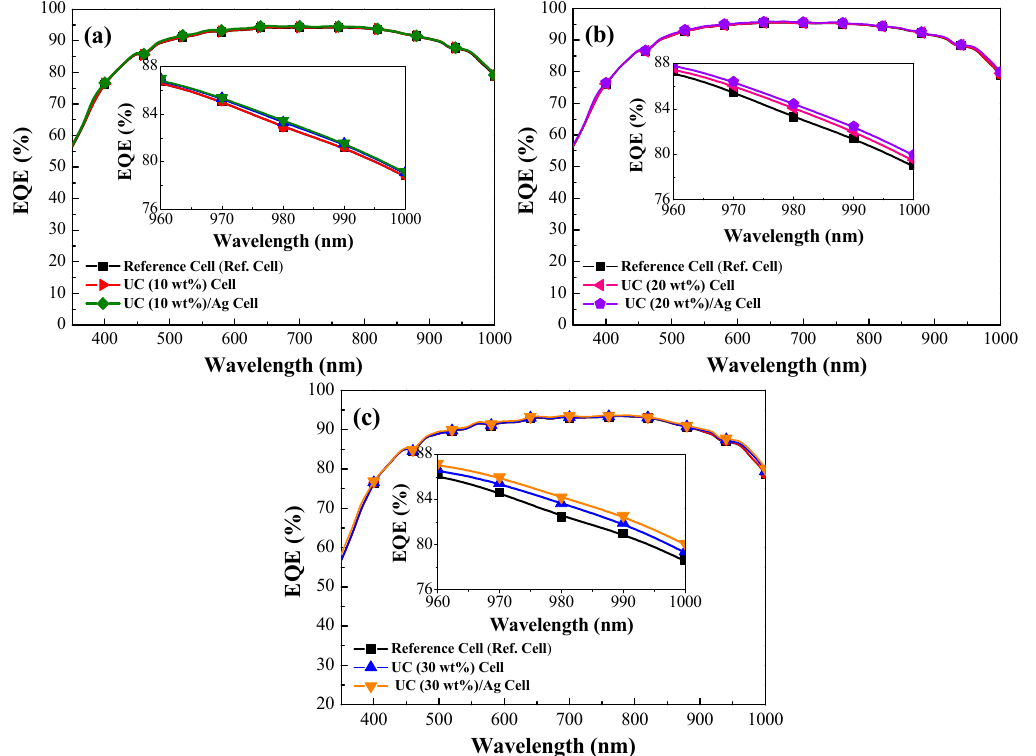
Figure 10. External quantum efficiency ( EQE ) response of reference cell, UC cell, and UC/Ag cell at phosphor concentration of ( a ) 10 wt%, ( b ) 20 wt%, ( c ) 30 wt %.